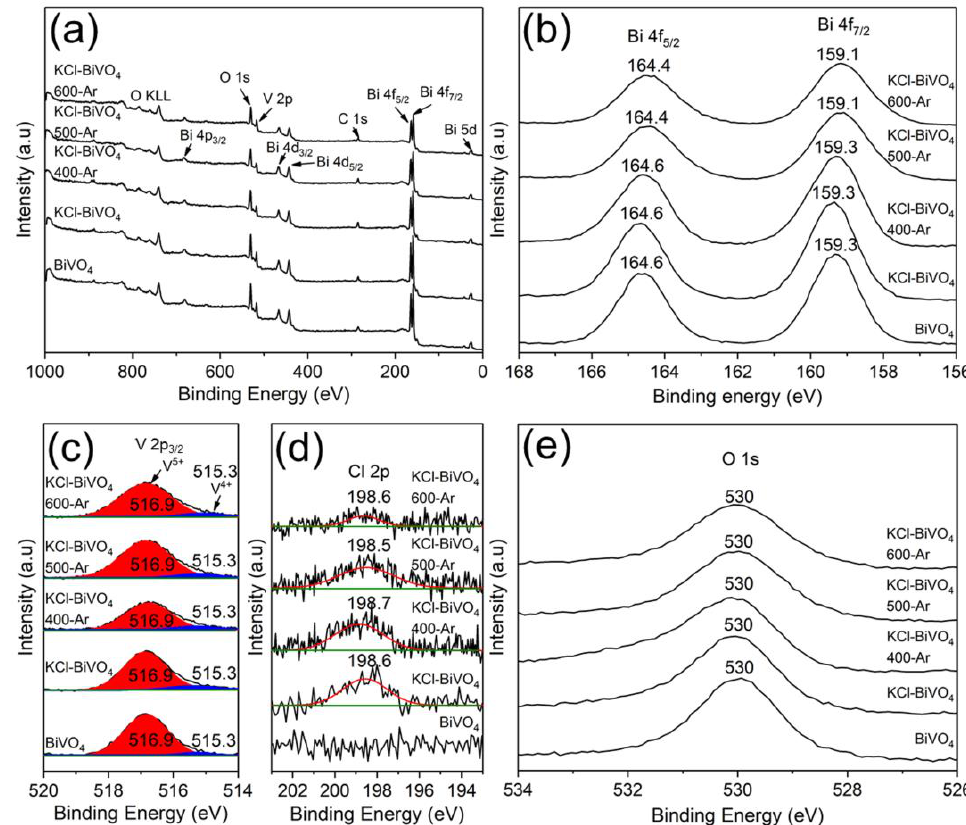
Figure 5. XPS survey spectra ( a ) of BiVO 4 , KCl-BiVO 4 and KCl-BiVO 4 calcined in Ar at different temperatures, and high-resolution XPS spectra of ( b ) Bi 4f, ( c ) V 2p, ( d ) Cl 2p, and ( e ) O 1s orbitals.